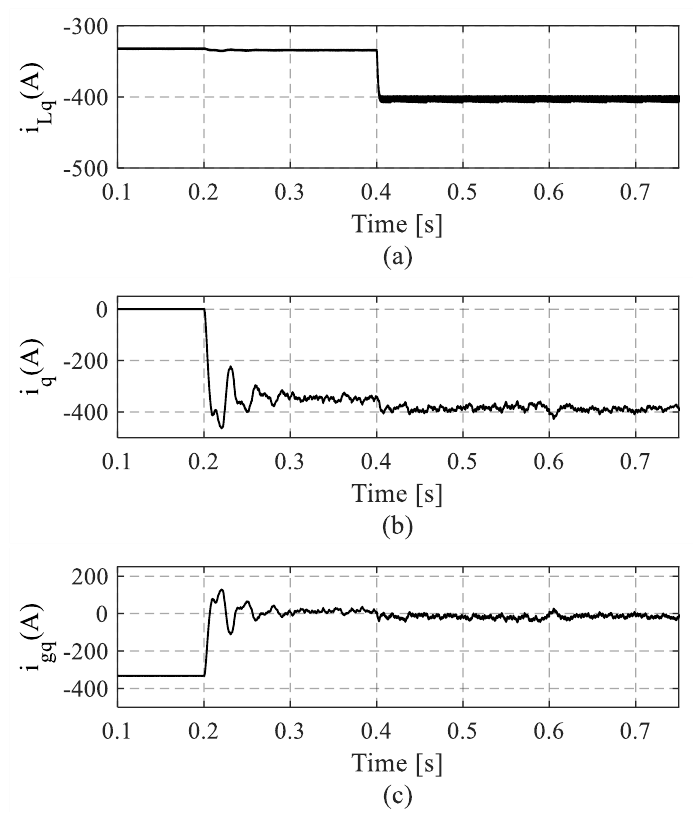
Figure 7. Reactive current components of the STATCOM model: ( a ) q component of load current; ( b ) q component of MMC current; and ( c ) q component of grid current.